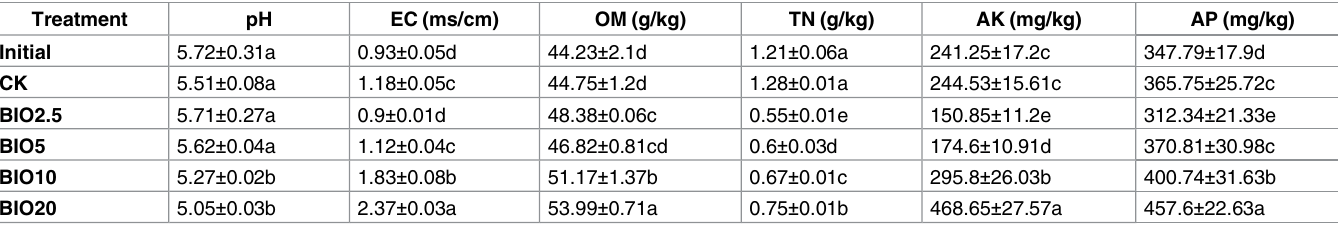
Table 3. Physicochemical properties of soils. Treatment